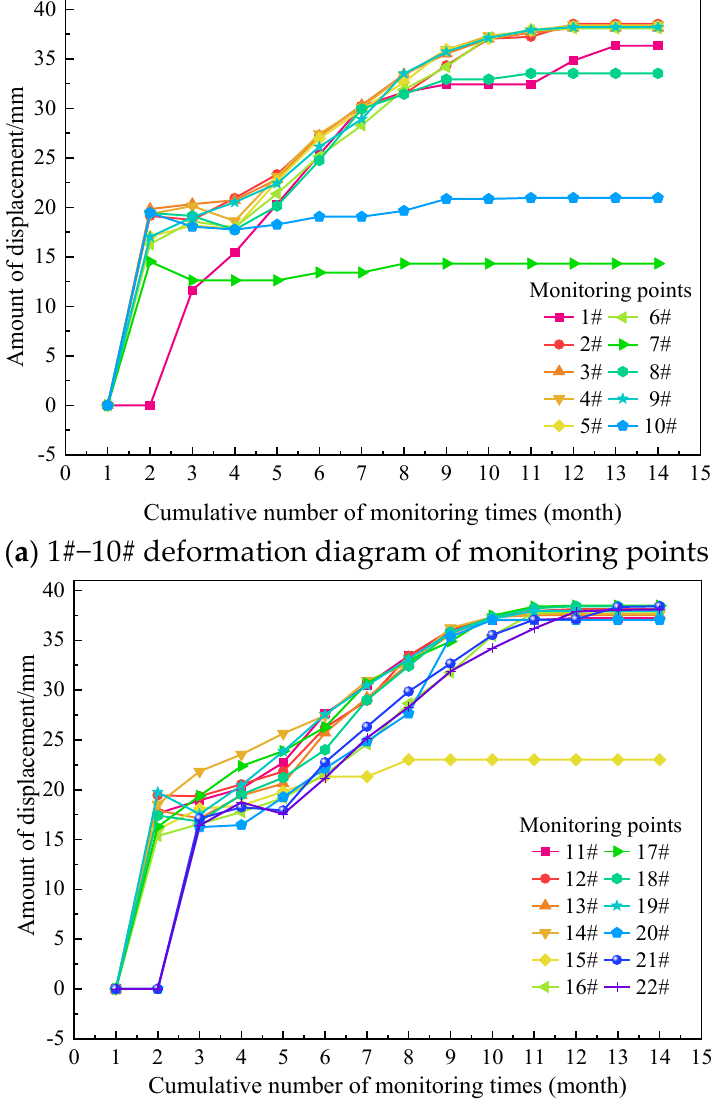
monitored deformation data converges until the horizontal displacement of the supporting structure is stable (see Figure 12 for the specific change of monitoring point).